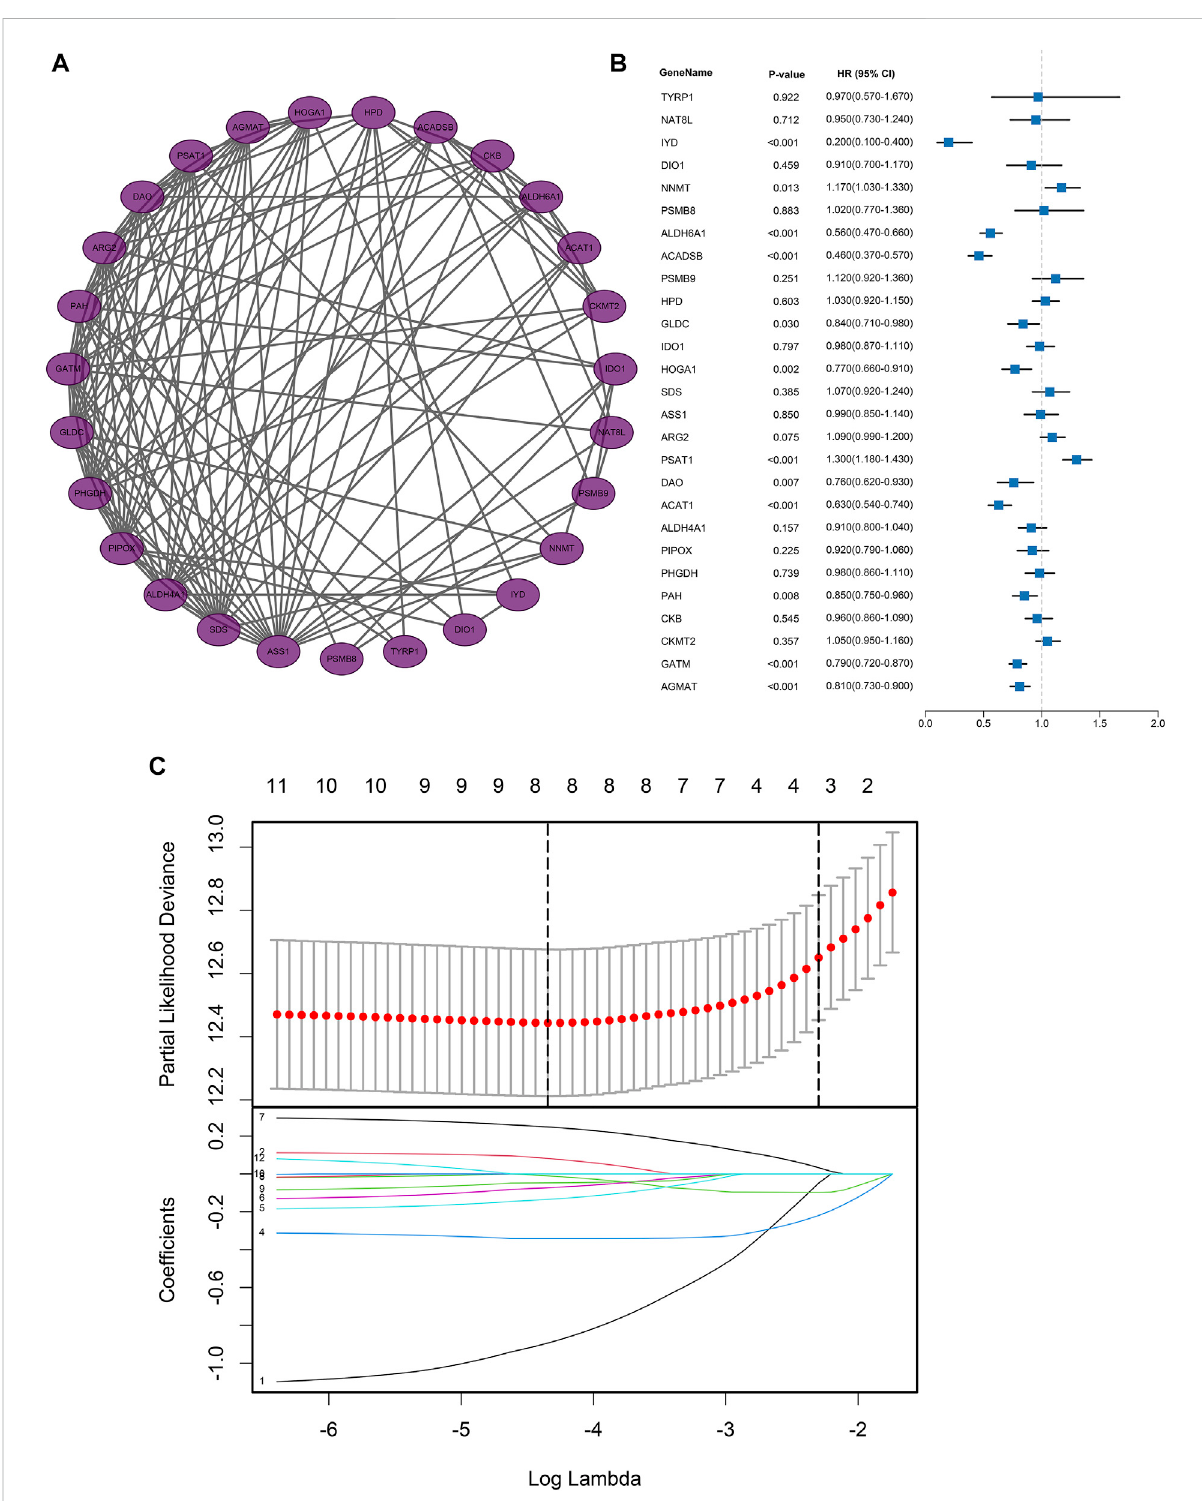
FIGURE 3 Protein-protein interaction network and regression analysis. (A) Protein-protein interaction network of AAM-related DEGs; (B) Univariate Cox regression analysis of AAM-related DEGs; (C) Lasso regression analysis of AAM-related